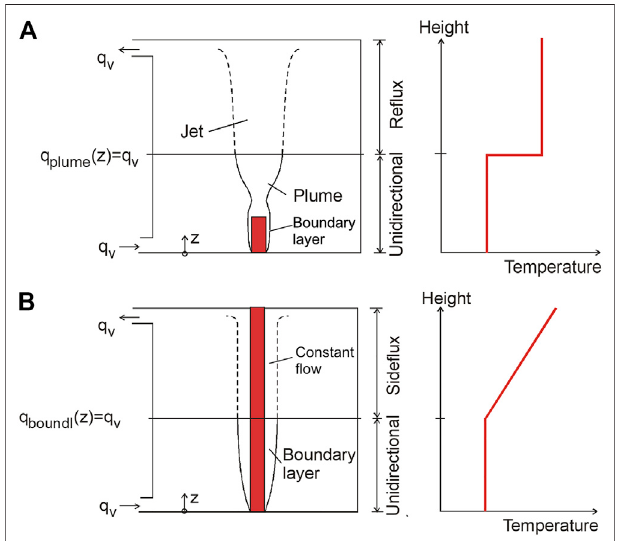
FIGURE 6 | (A) Short buoyancy source (B) Buoyancy source spans the whole height of the room. The temperature is the temperature in the ambient air based on paragraph 8.9.6 in the study by Etheridge and Sandberg (1996).